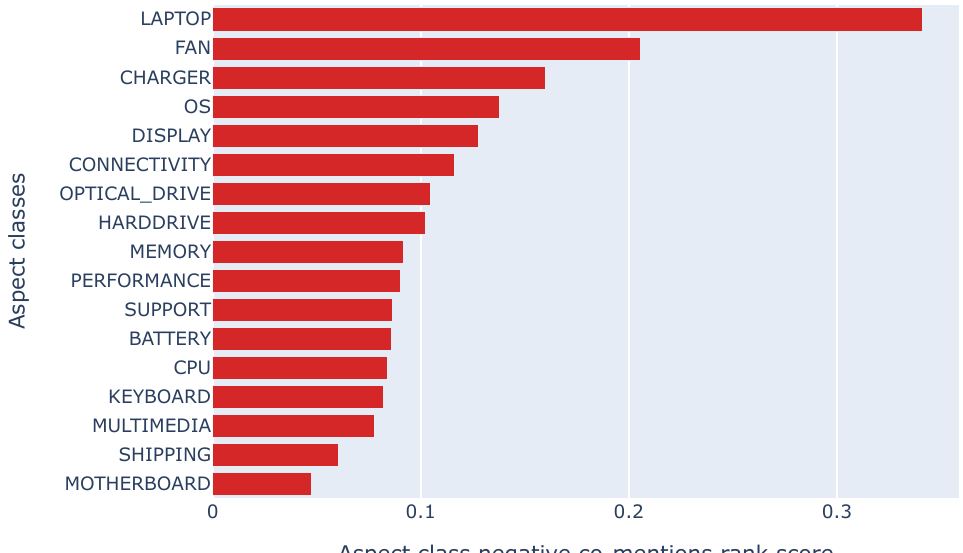
Figure 10. Product aspect class ranking across all opinions.